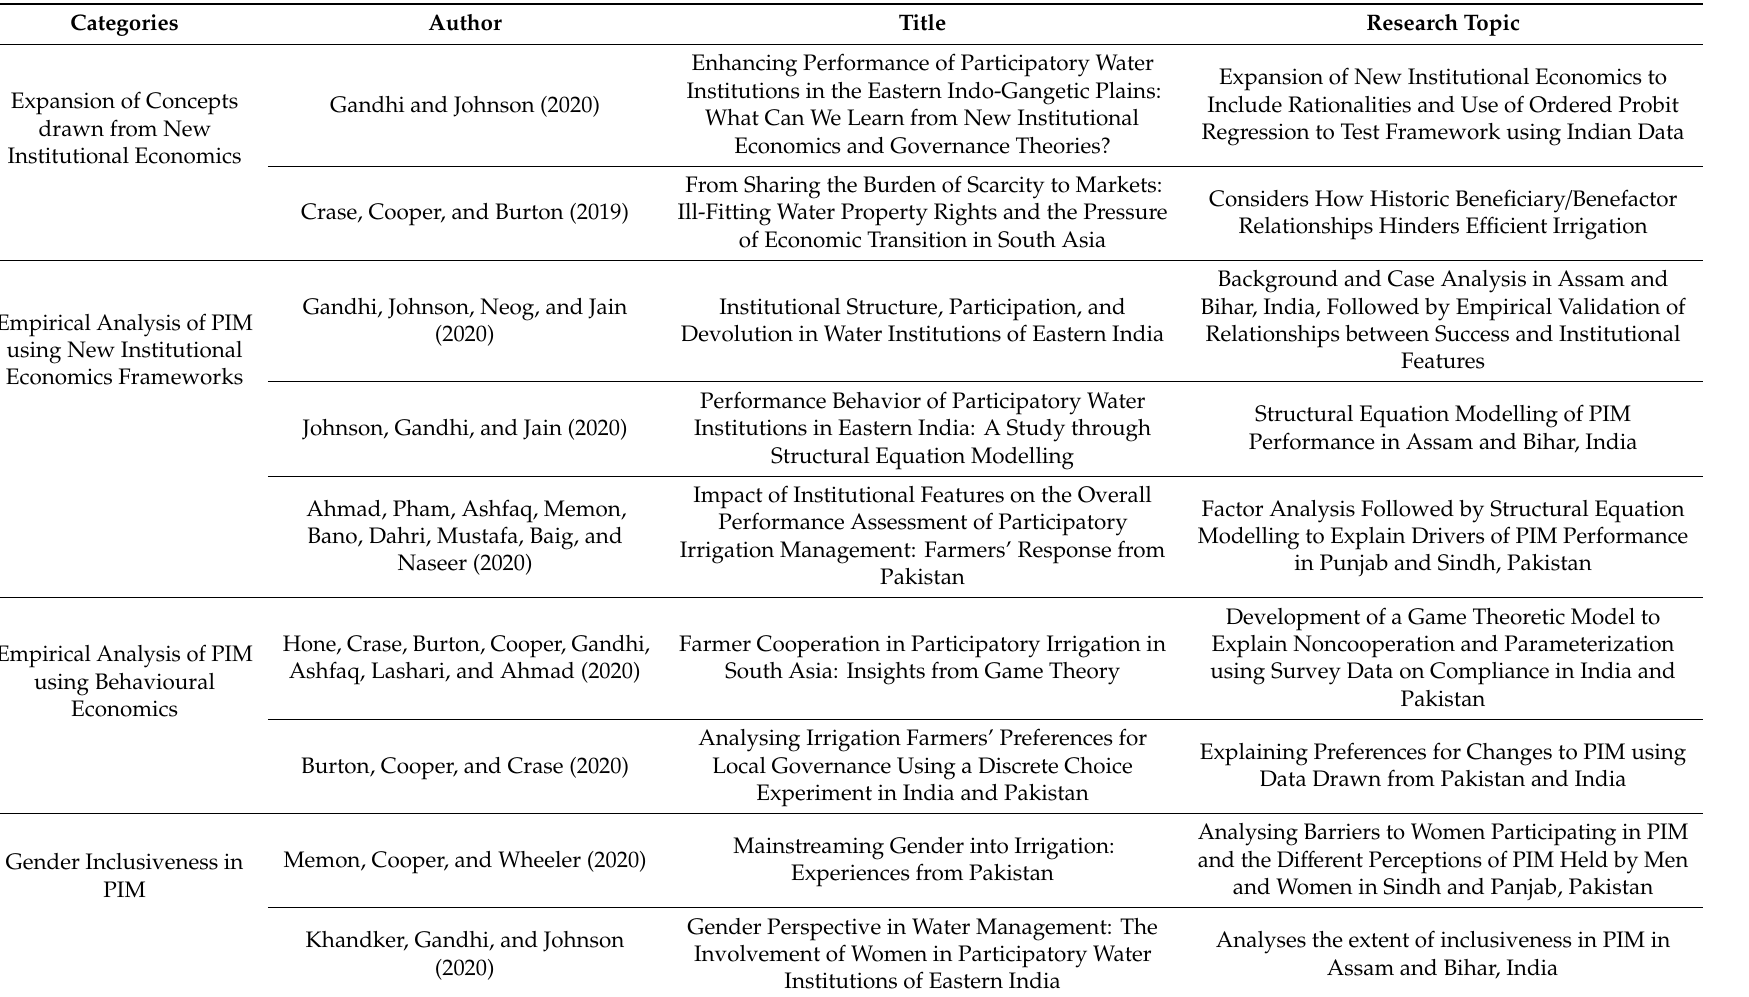
Table 1. Works published in the Special Issue “Using Applied Economics to Study Participatory Irrigation Institutions and their Impact in South Asia”. Categories, authors, title, and topic are briefly